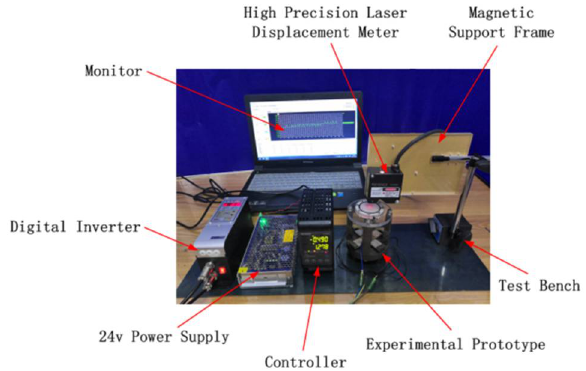
Figure 5. Displacement measurement device.